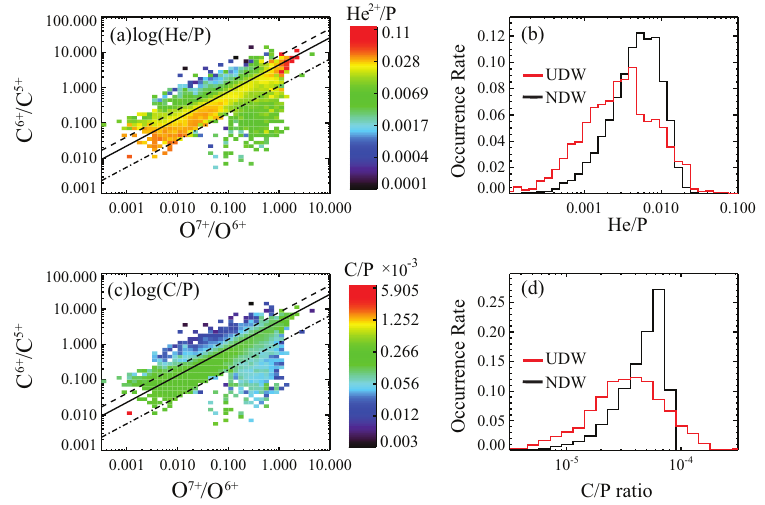
Figure 1. ( Left ) distributions of all non-ICME solar wind (January 1998–August 2011). ( a ) He/P ratio and ( c ) C/P ratio in the log(C 6 + /C 5 + ) and log(O 7 + /O 6 + ) space. The black solid line is the linear fit of the whole solar wind distribution in 2007, the dashdotted black lines are the threshold by which the Outliers are selected (see Zhao [13] for details). The dashed black lines on the upper-boundary of this plot are one of the thresholds we use to select the UDW in this study. ( Right ) histograms of the He/P ratio ( b ) and C/P ratio ( d ) in the UDW (red) and NDW